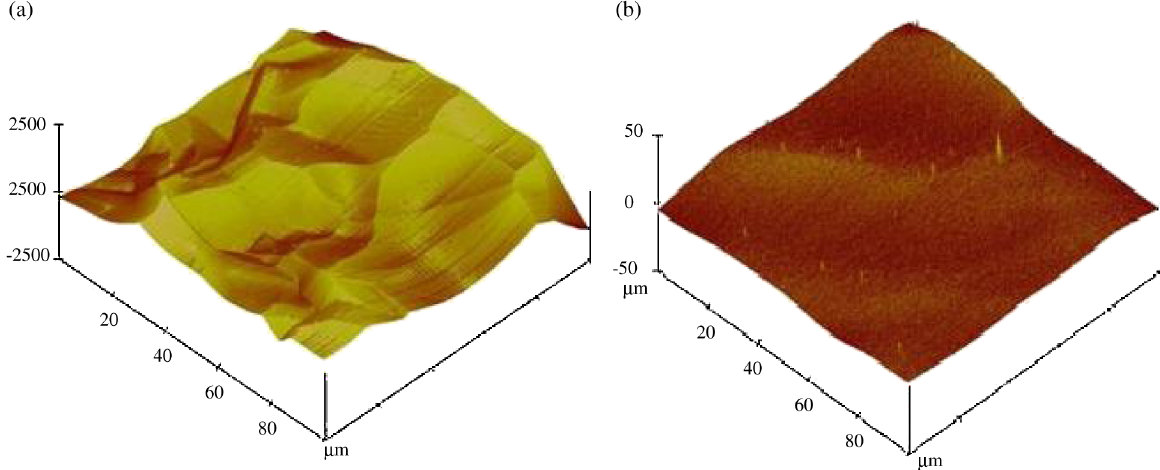
FIG. 3. Topography images created from AFM data (a) after BCP and (b) after EP treatment, the same samples as in Fig. 2. The horizontal scales are both 100 (cid:1) m by 100 (cid:1) m and the vertical scales are 2500 and 50 nm, respectively.